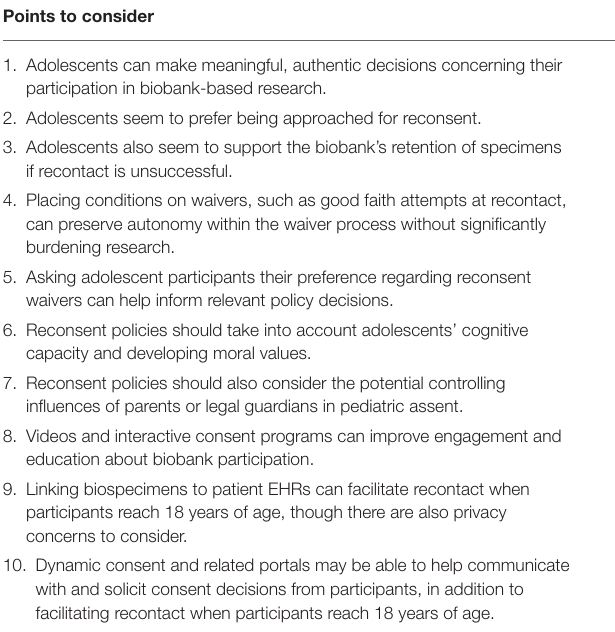
TABLE 1 | Key considerations for adolescent assent and reconsent. Points to